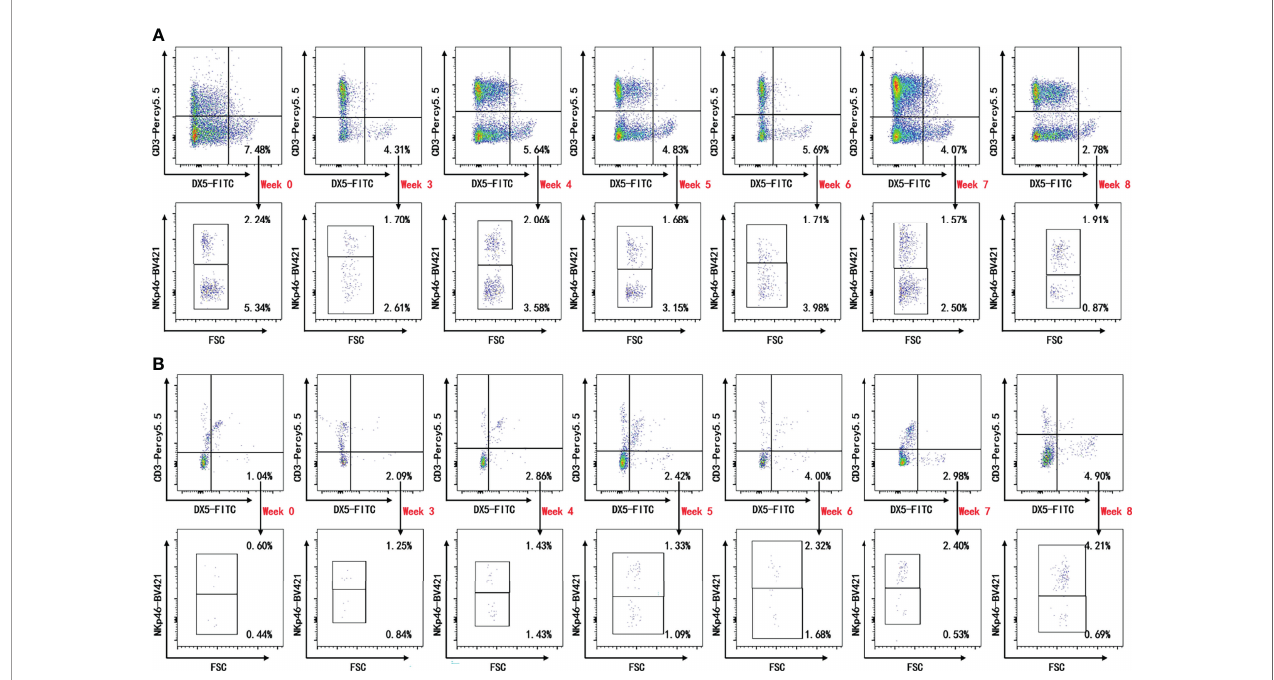
FIGURE 2 | Representative plots of cytometric analysis. Flow cytometric analysis for indicated time points. Single live lymphocytes in peripheral blood (A) and paws (B) gated on CD3 − DX5 + were further gated for NKp46. The gates were set upon isotype